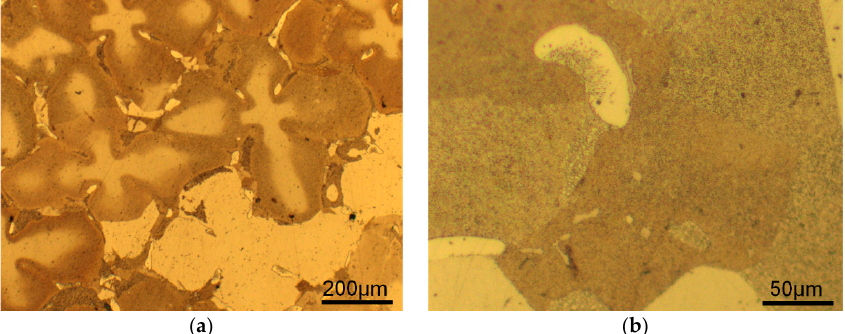
Figure 8. Influence of microstructural heterogeneities on the RX behavior of S-980-2. ( a ) DA and IDRs; ( b ) eutectic particle.